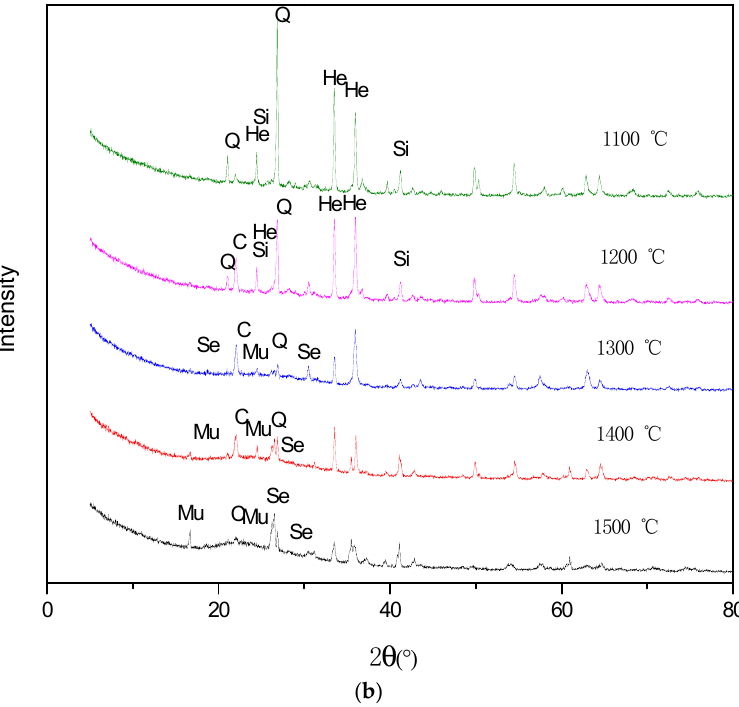
Figure 9. XRD patterns of the ash under oxidized atmosphere (1100–1500 °C). ( a ) Ulanqab lignite; ( b ) Ulankarma lignite. Q—quartz; An—anorthite; He—hematite; H—hercynite; Se—sekaninaite;